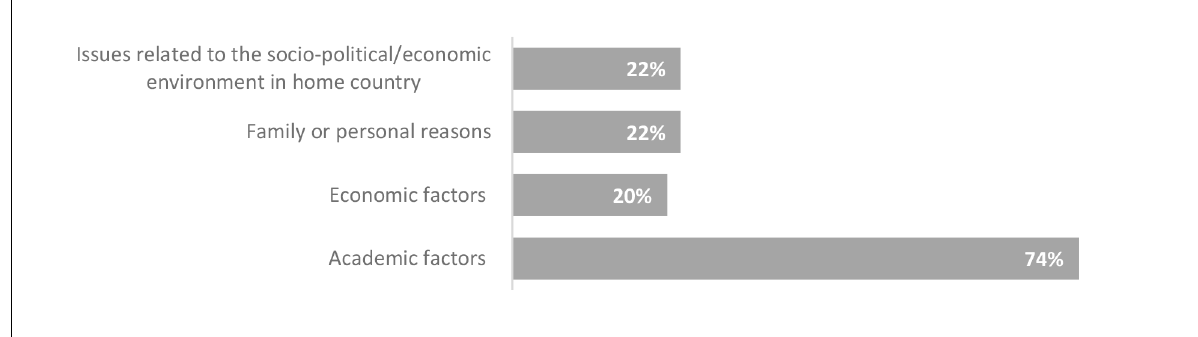
Figure 5: Reasons given by doctoral graduates from Africa for remaining in South